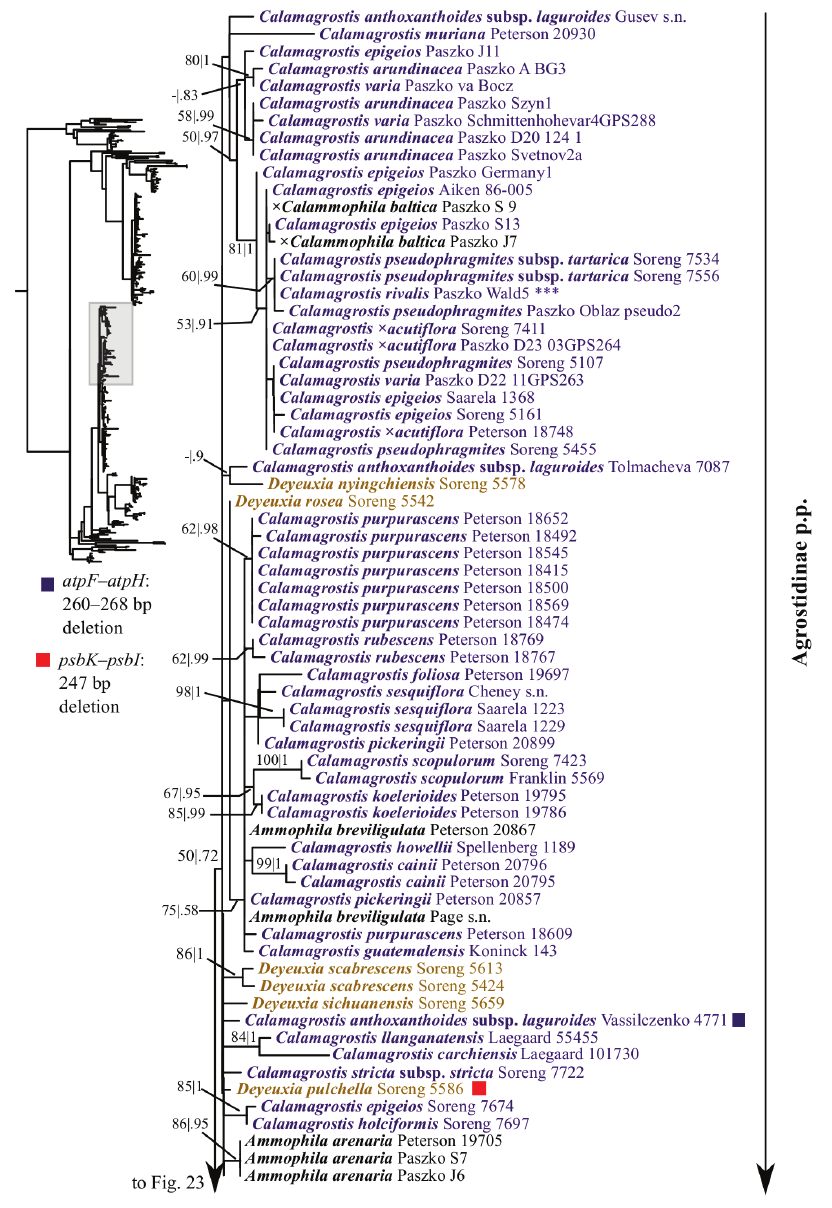
Figure 22. A portion (part of Agrostidinae p.p.) of the maximum likelihood phylogram inferred from combined plastid data ( atpF–atpH , psbK–psbI , psbA–rps19–trnH , matK , trnL–trnF ). ML bootstrap sup- port (left) and BI poster probabilities (right) are recorded along branches. A dash indicates bootstrap support <50%. No support is shown for branches with bootstrap support <50% and posterior probability <.5. The shaded area of the smaller tree on the left indicates the location in the overall tree of the portion shown. Placement of the sample with asterisks (***) is incongruent in nrDNA and plastid trees. One indel in psbK–psbI and one in atpF–atpH are mapped onto the